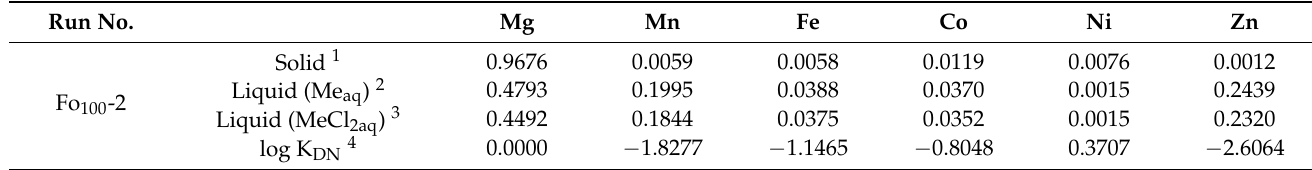
Table 2. Experimental results for the olivine solid solution–(Ni 2+ , Mg 2+ , Co 2+ , Zn 2+ , Fe 2+ , Mn 2+ )Cl 2 – H 2 O system at 700 °C and 100 MPa.